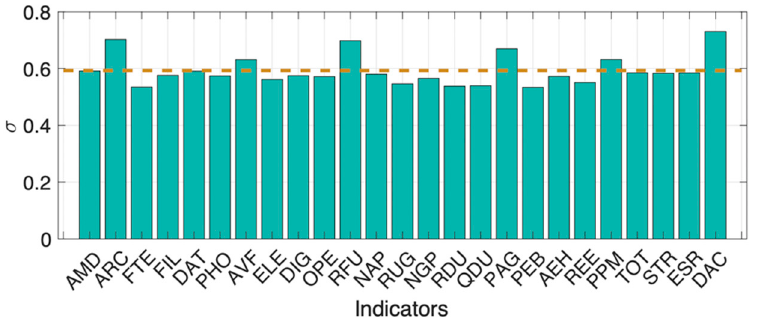
Figure 3. Gaps among different years under different indicators. The red line represents the mean value.